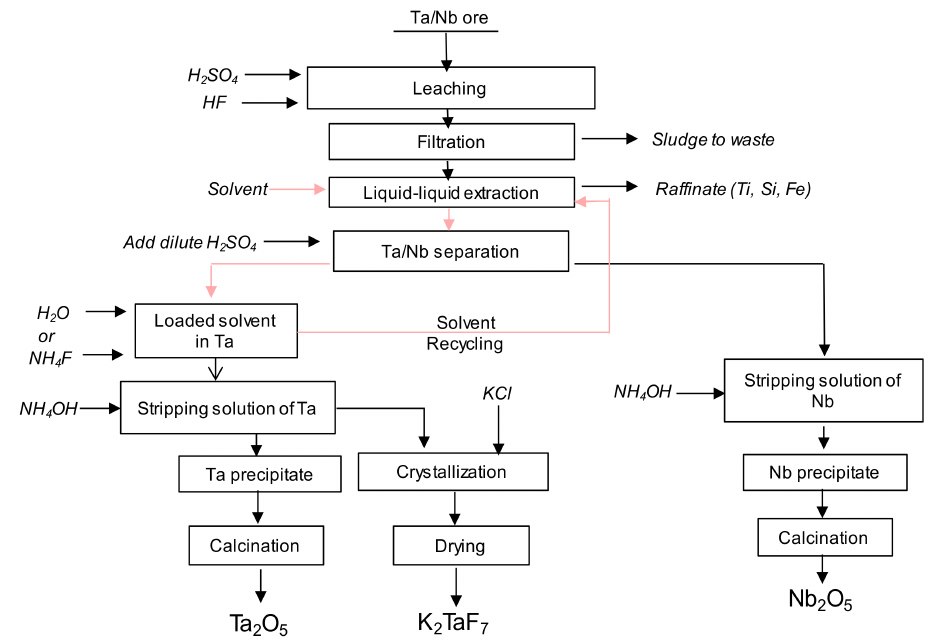
Figure 1. Process scheme for Ta and Nb production (data from